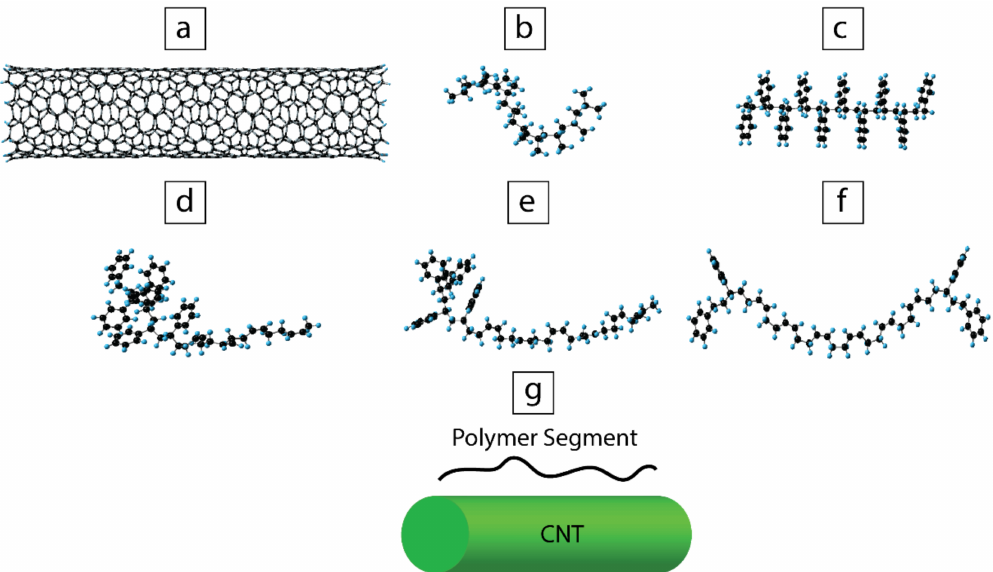
Figure 2. Optimized geometries of ( a ) 5,9-chiral carbon nanotubes (CNT) segment, ( b ) polypropylene (PP) segment (10 repeating units), ( c ) polystyrene (PS) segment (10 repeating units), ( d ) styrene-butadiene (SB) diblock copolymer segment S6B4, ( e ) SB diblock copolymer segment S4B6, ( f ) styrene-butadiene-styrene (SBS) triblock copolymer segment S2B6S2, and ( g ) schematic of the initial configuration of polymer segment/CNT assembly. The green cylinder represents CNT, and polymer segment corresponds to PP, PS, or